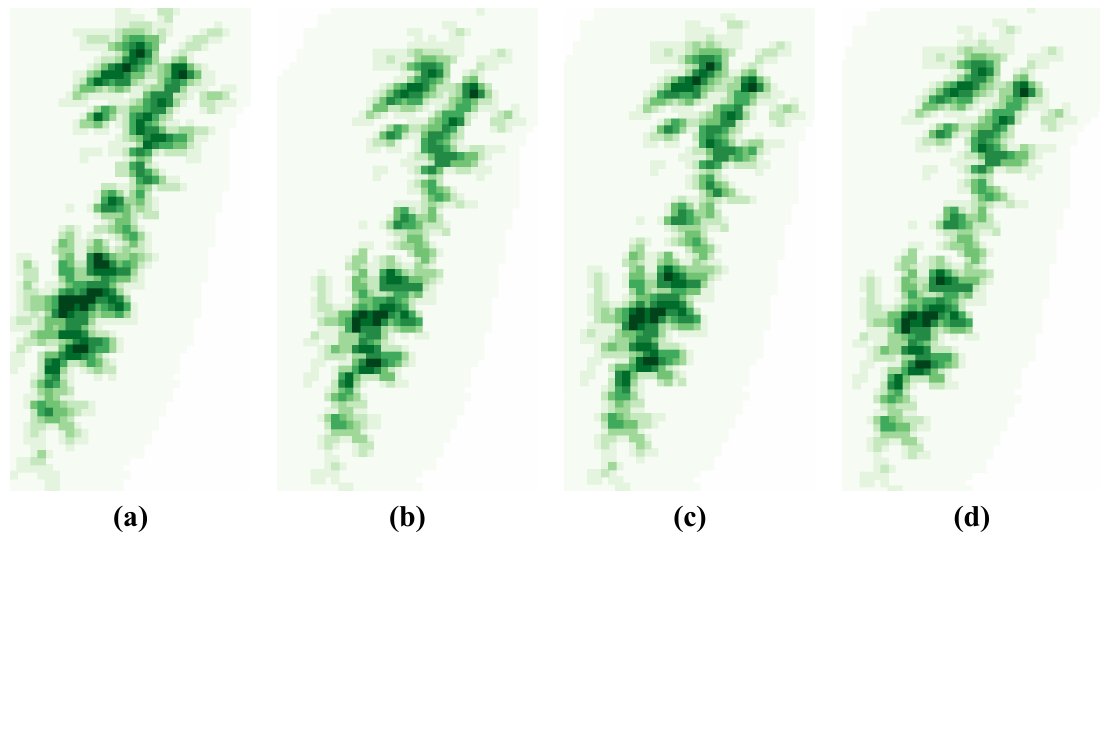
Figure 3. Predicted habitat suitability in Central Mountain Range area for Abies in 12 future scenarios (3 GES × 2 GCM × 2 parameter) for